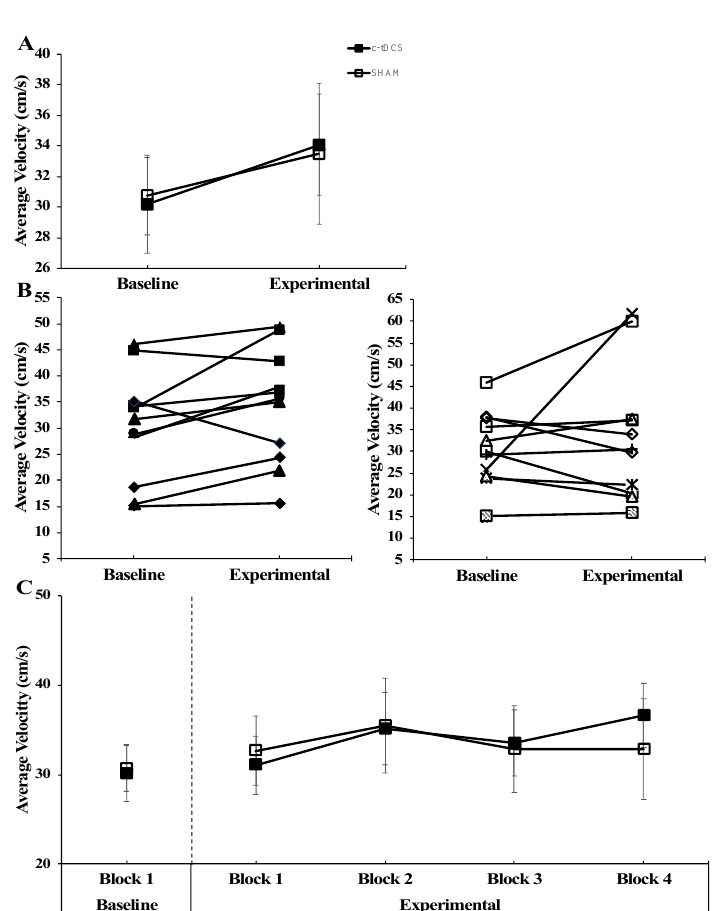
Figure 5. Average velocity for the arm movement task (AMT) for the cerebellar transcranial direct current stimulation (c-tDCS) (closed squares) and SHAM groups (open squares) in the Baseline and Experimental conditions. ( A ) The movement velocity was not significantly different between c-tDCS and SHAM groups ( p = 0.994) or for the Baseline and Experimental conditions ( p = 0.134). ( B ) Individual average velocity data corresponding to the data in Panel (A) for the 11 participants in the c-tDCS group and 11 participants in the SHAM group. ( C ) For illustrative purposes, the individual AMT trial blocks corresponding to the average data presented in Panel (A) are depicted. It can be seen that there is no trend for movement velocity to improve with trial block number to a greater extent in the c-tDCS group compared with the SHAM group due to the accumulating stimulation